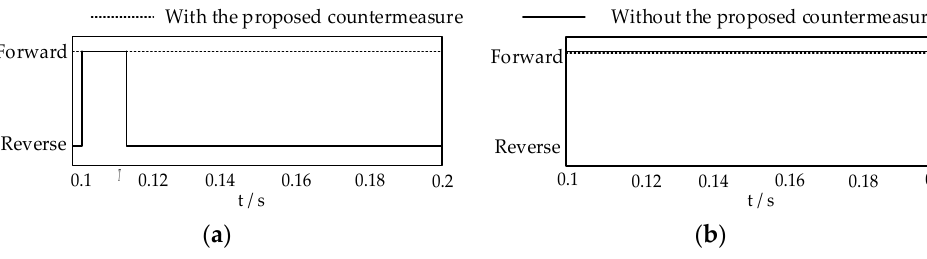
Figure 20. Operation results of the directional relay with and without the proposed countermeasure in Case 4 ( a ) busbar n ; and ( b ) busbar m .